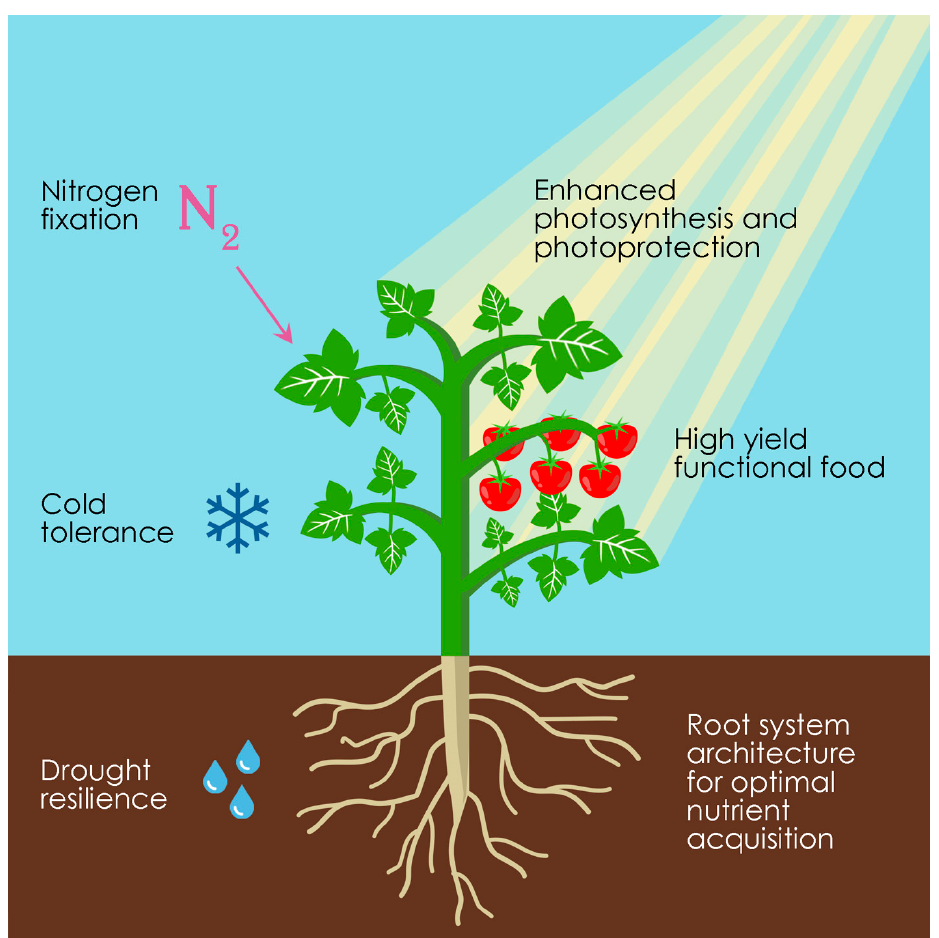
Figure 1. Synthetic biology applied for enhancing plant performance. Different traits that can be engineered simultaneously to take full advantage of plants on Mars (and